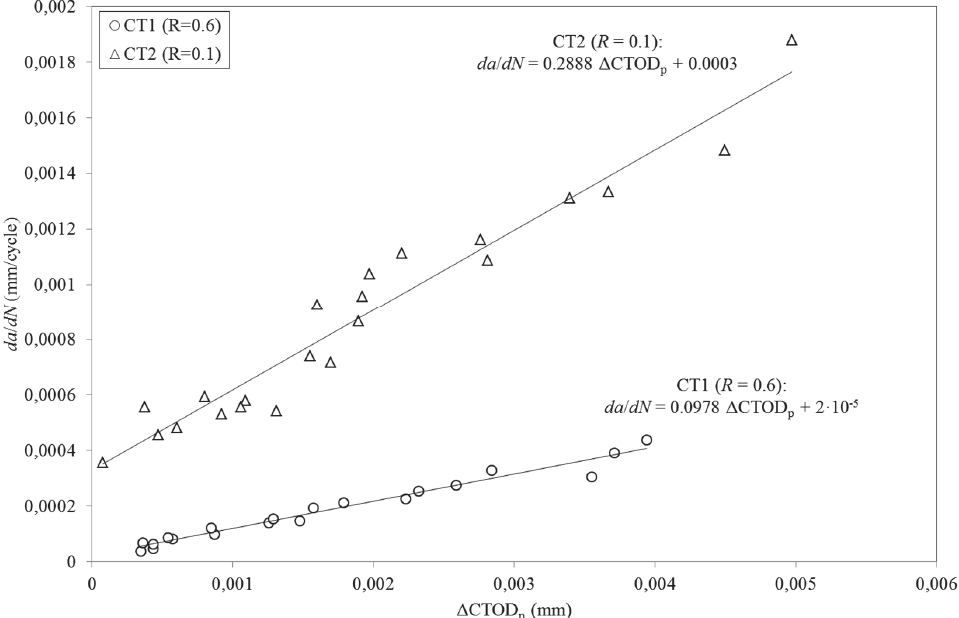
Figure 9: Crack growth per cycle ( da / dN ) versus plastic CTOD range ( Δ CTOD p ) for both